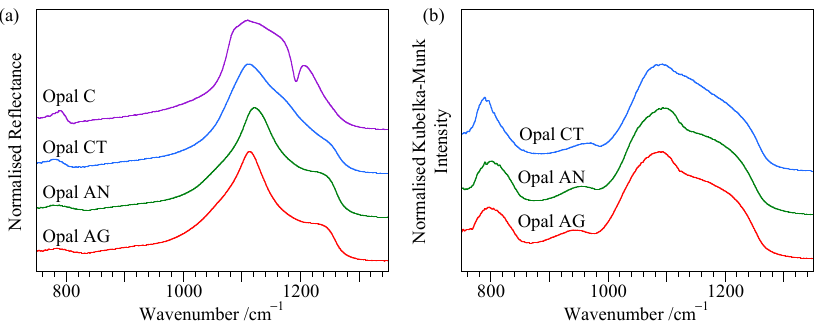
Figure 8. Polarised 75° angle of incidence specular reflectance spectra of polished thin segments. ( a ) Predicted spectra Figure 8. Polarised 75 ◦ angle of incidence specular reflectance spectra of polished thin segments. in the mid-section (presumed to be silanol), with shallow peaks visible at approximately calculated using the complex refractive index determined from 15° measurements and ( b ) measured spectra. From top to ( a ) Predicted spectra calculated using the complex refractive index determined from 15 ◦ measure- 945, 955 and 970 cm − 1 for opal-AG, opal-AN and opal-CT, respectively. Curve fitting using bottom, the samples are opal-AG (CP-2 from Coober Pedy, South Australia, Australia), opal-AN (MS-1 from Mount Gaussian line shapes resolved these to 937, 948 and 957 cm − 1 , respectively, with FWHM of ments and ( b ) measured spectra. From top to bottom, the samples are opal-AG (CP-2 from Coober Squaretop, Queensland, Australia), opal-CT (G9942 from Angaston, South Australia, Australia) and opal-C (T1664 from Guanajuanto, Mexico). Spectra in green represent p -polarised spectra and those in blue are s -polarised. approximately 55 cm − 1 in all cases. Similar fitting of the TO 3 /LO 3 region showed no signif- Pedy, South Australia, Australia), opal-AN (MS-1 from Mount Squaretop, Queensland, Australia), icant differences between the opal types, with average peak positions of 1089 ± 8 and 1203 opal-CT (G9942 from Angaston, South Australia, Australia) and opal-C (T1664 from Guanajuanto, Kubelka–Munk-corrected diffuse reflectance spectra (Figure 9b) were similar to those ± 6 cm − 1 . Equivalent FWHM were 121 ± 9 and 95 ± 6 cm − 1 . There were no differences with Mexico). Spectra in green represent p -polarised spectra and those in blue are s -polarised. for transmission and specular reflectance with peaks at 797, 800 and 789 cm − 1 for the me- polarised radiation. dium-energy bands for opal-AG, opal-AN and opal-CT, respectively. The peak for opal- A was again at higher energy and broader than for opal-CT. Clear differences were seen